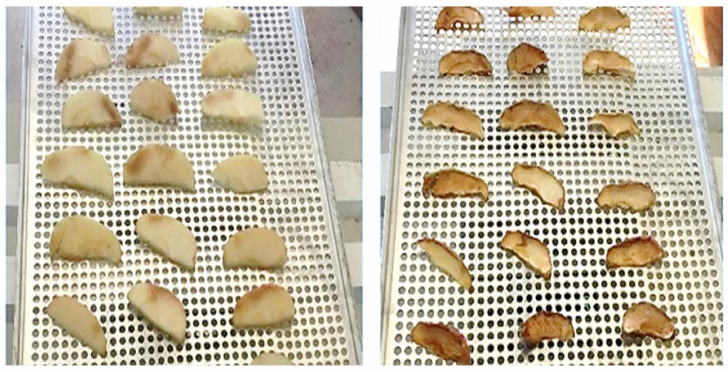
Figure 5. Images of apple products before and after